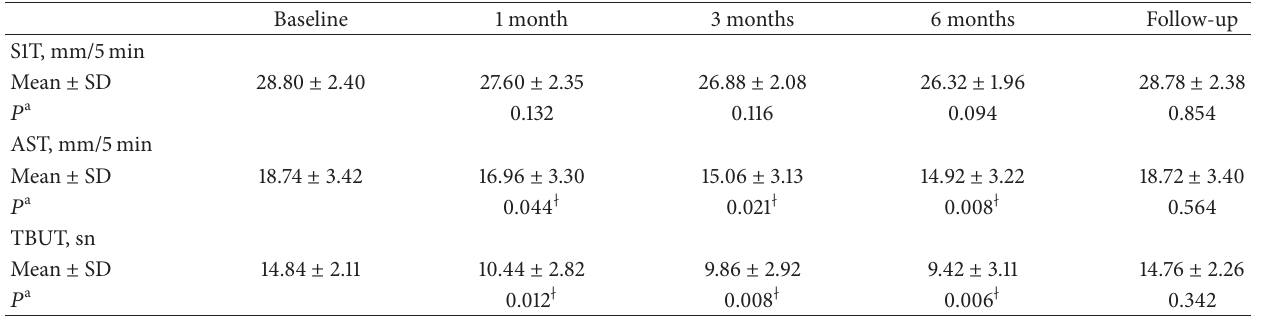
Table 1: Changes of Schirmer 1 test, anesthetized Schirmer test, and tear break-up time of the patients.